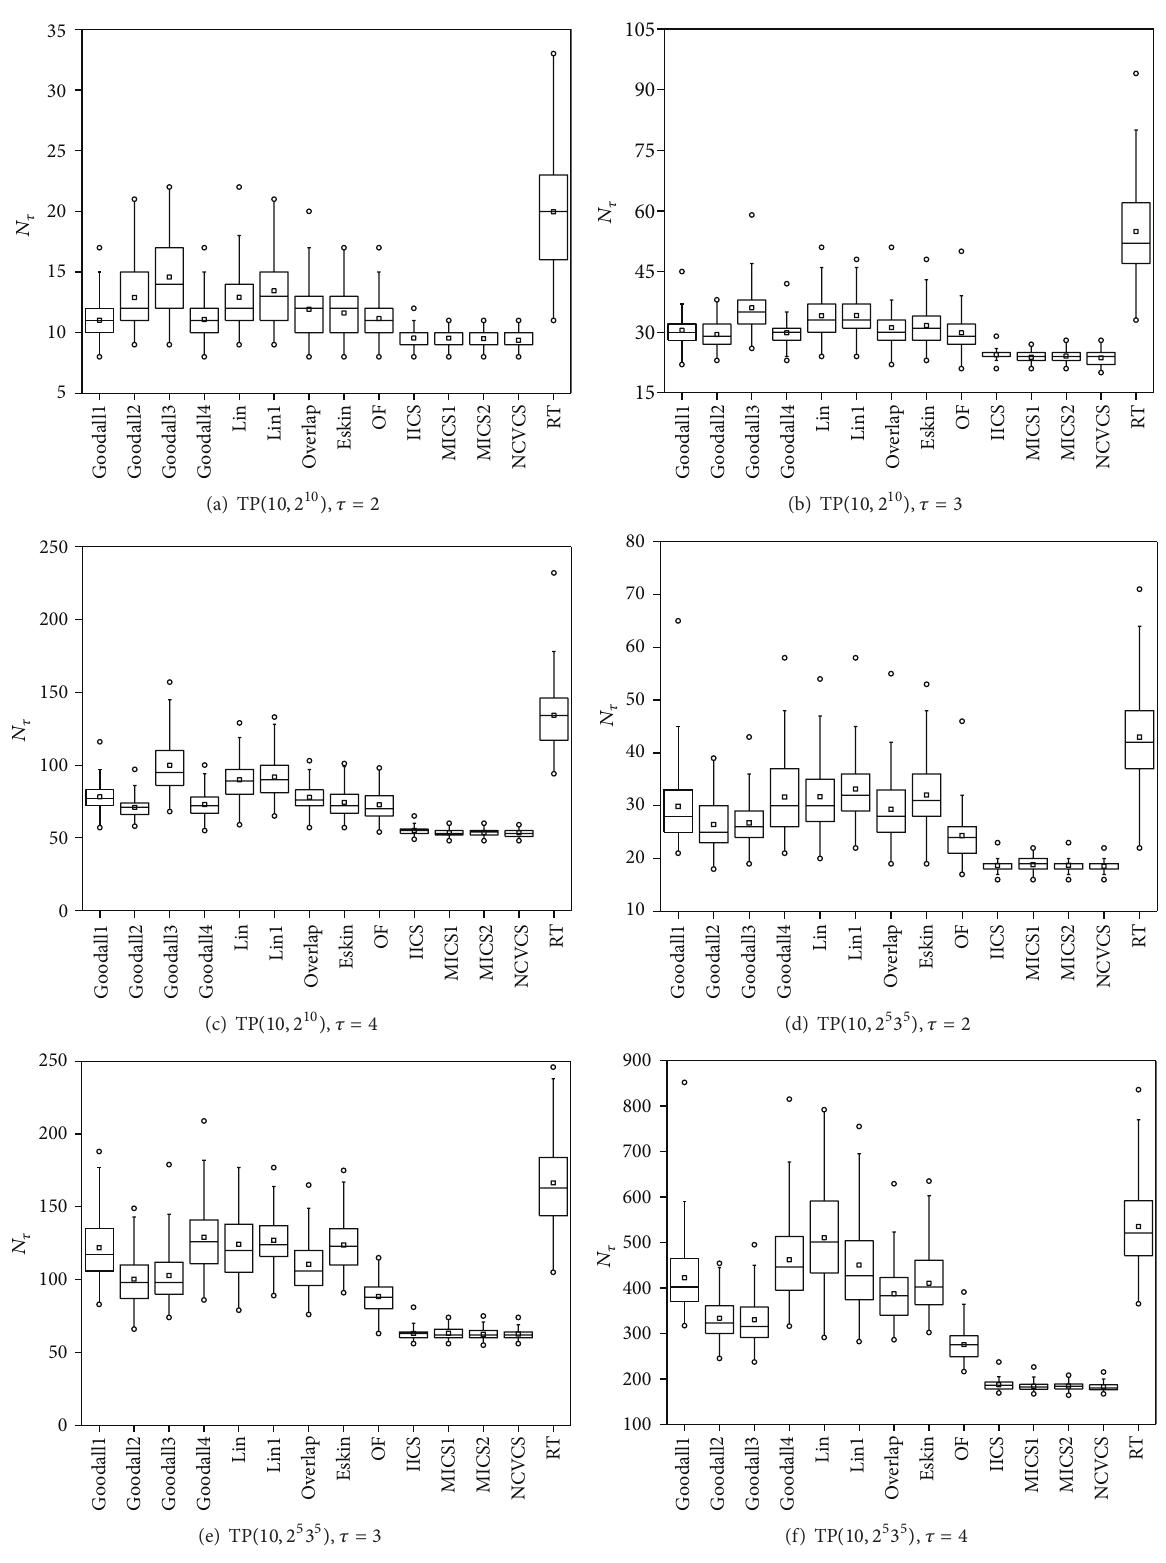
Figure 3: The 𝑁 𝜏 metric for different test case generation